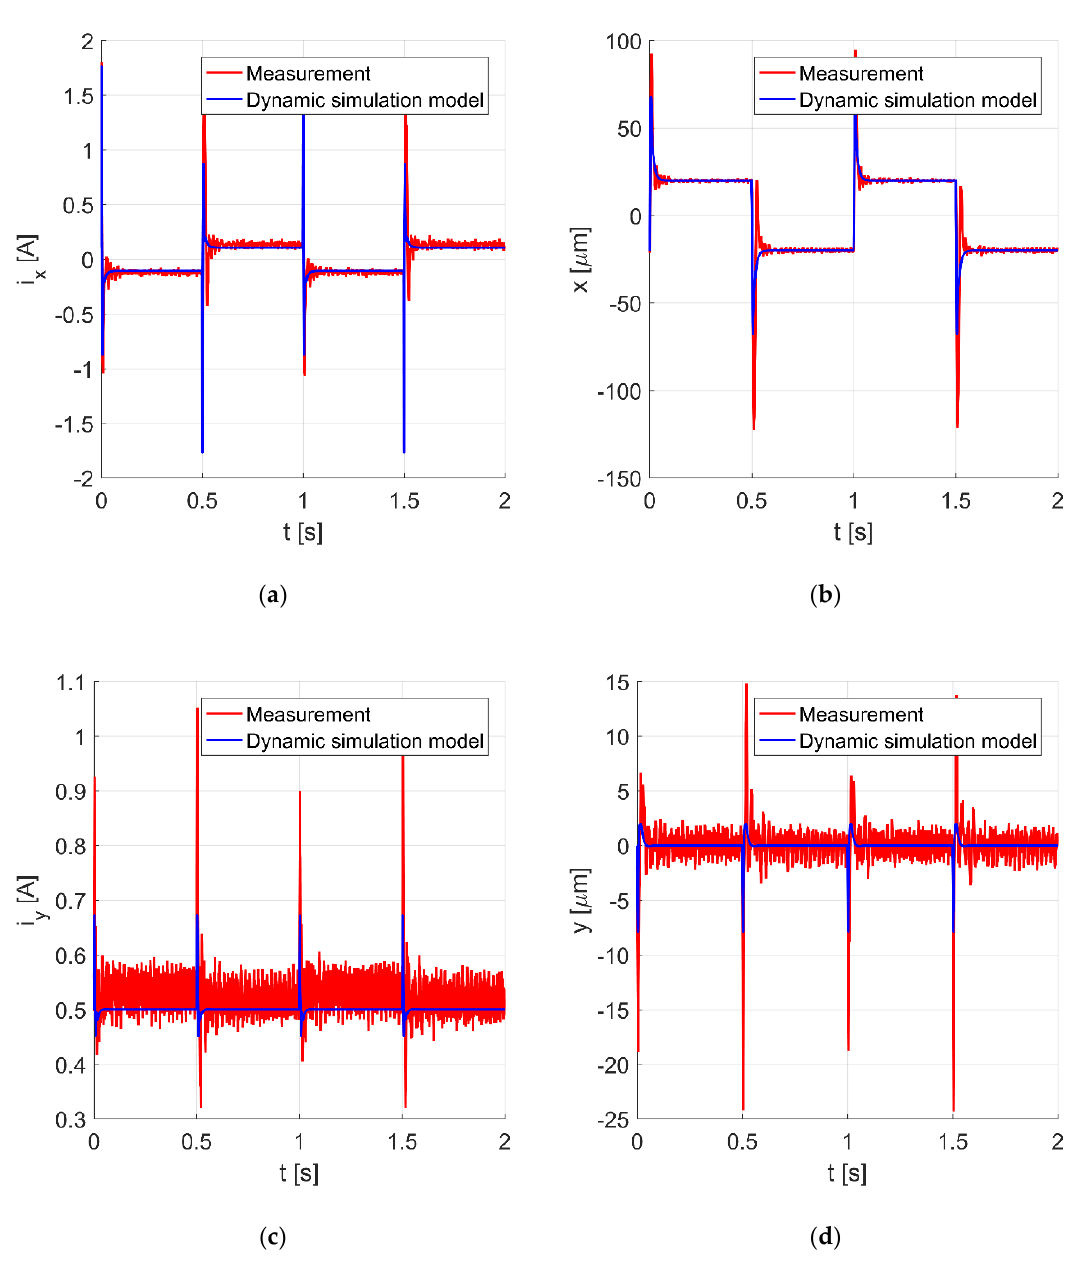
Figure 7. The control current i x ( a ), the rotor position along the x -axis ( b ), the control current i y ( c ), and